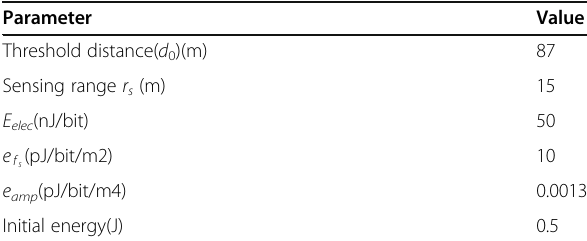
Table 1 Network